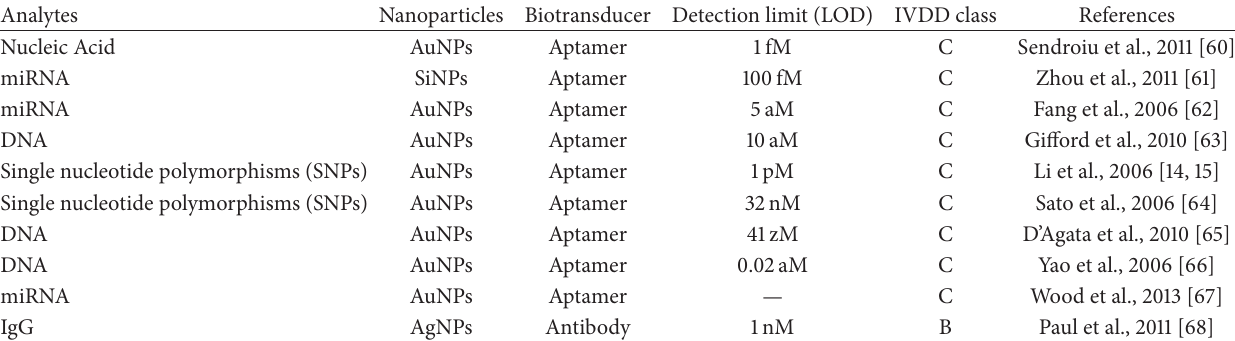
Table 5: Main analytical performances of the reviewed biosensors based on SPR imaging.